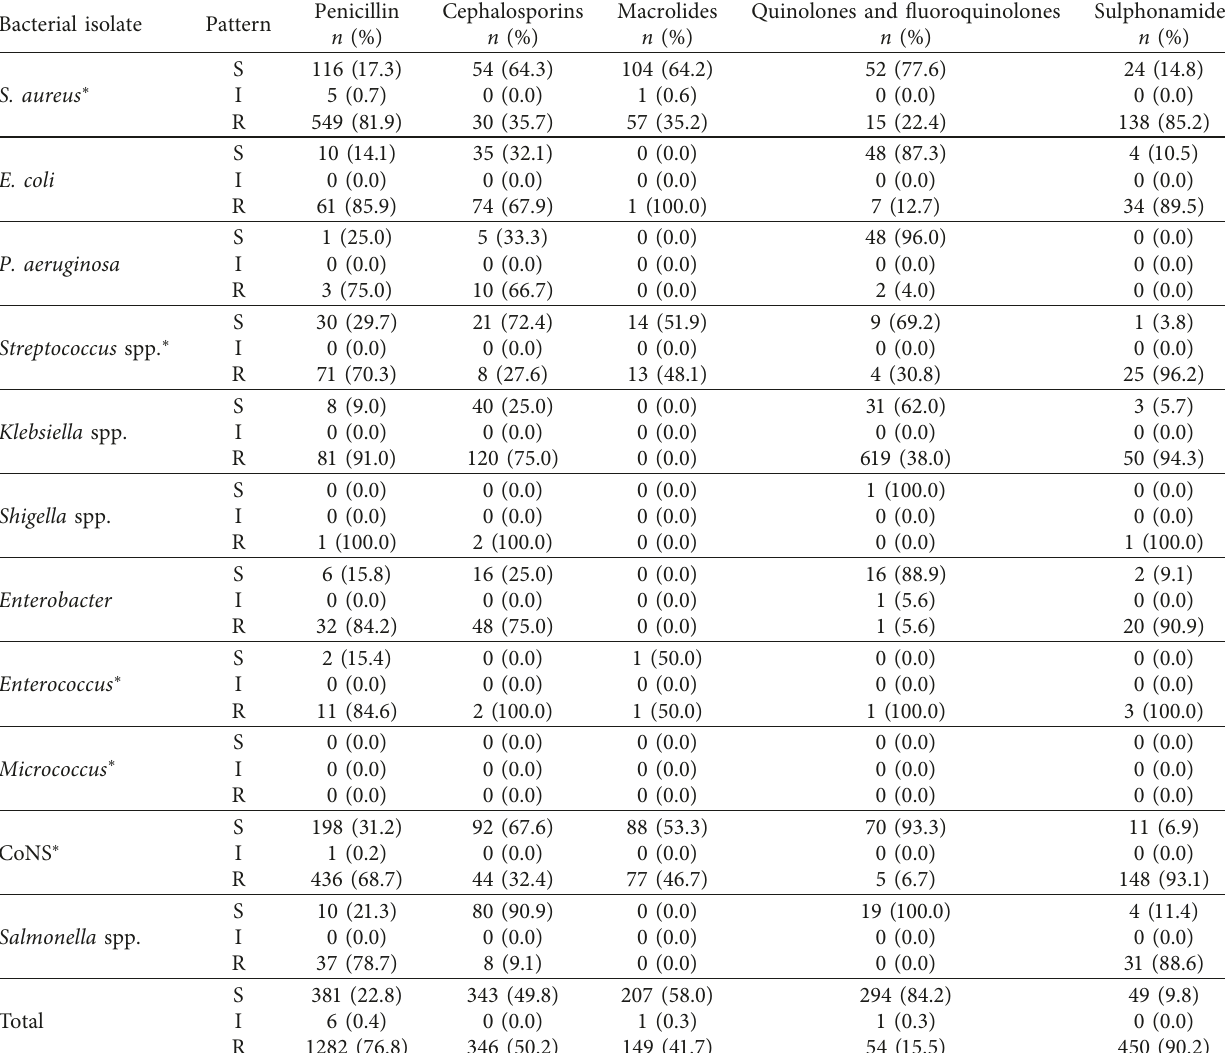
Table 3: Antimicrobial susceptibility pattern of bacterial isolates from blood culture at St. Dominic Hospital in Akwatia. Bacterial isolate